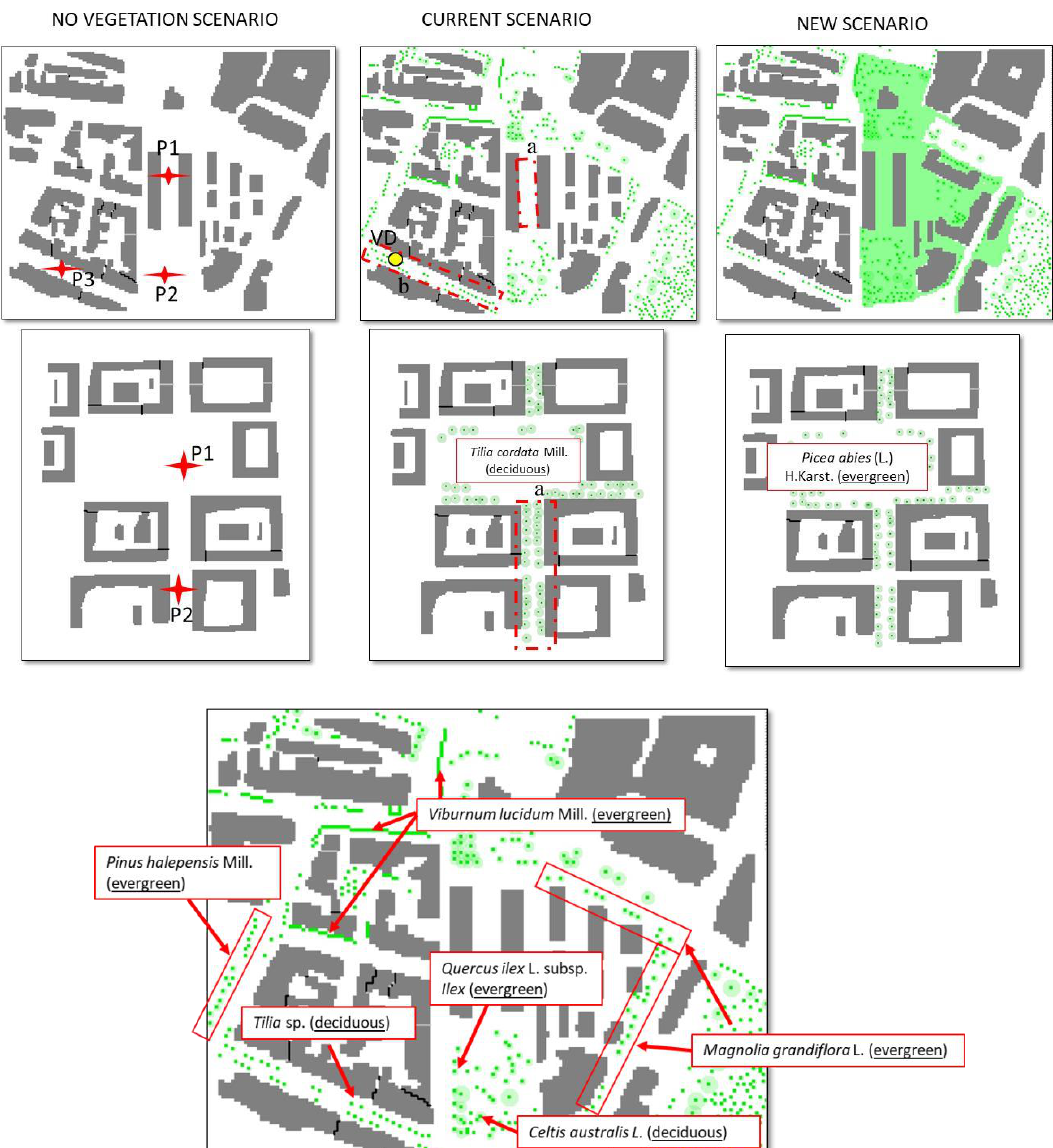
Figure 3. Investigated scenarios of the San Pio neighbourhood in Lecce (top) and the Aleksanterinkatu neighbourhood in Lahti (middle), with indication of the deciduous and evergreen species in Aleksanterinkatu, the investigated points P1, P2 and P3, the measurement position denoted by the yellow dot “VD” in the current scenario of San Pio and the investigated street canyons denoted by the red dotted line. Some evergreen species, deciduous species and hedge species present in the current scenario of San Pio (bottom) (base maps from Spaces tool of ENVI-met model, see Section